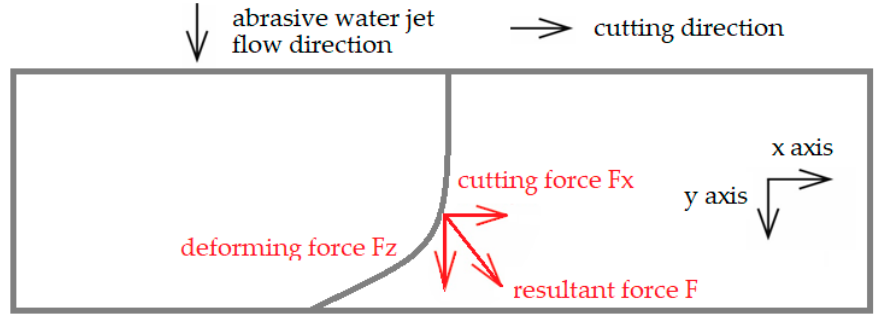
Figure 1. Cutting and deforming forces acting on the